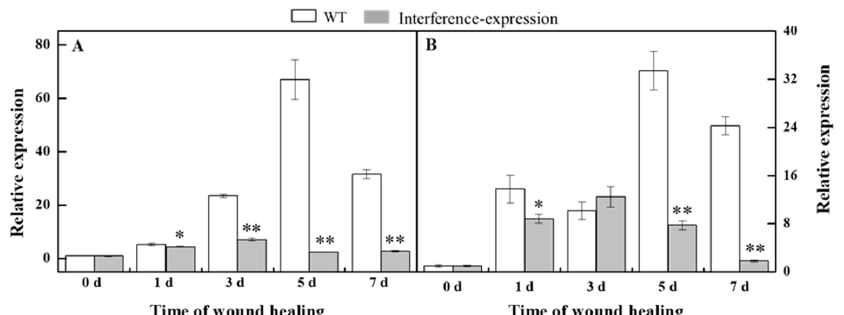
Figure 4. The interference expression of StMSD downregulated the gene expression of StPAL ( A ) and StC4H ( B ) in tubers during healing. The potato elongation factor 1-alpha 1 ( efla) was used as an internal control to normalize the data. Bars indicate standard deviation (±SD). Asterisks represent significant differences (* p < 0.05; ** p < 0.01). Each column represents the mean of three replicates. The healing was carried out at ambient temperature (20–25 ◦ C; RH 80–90%) in the dark. The four RNAi lines were used in the experiment.